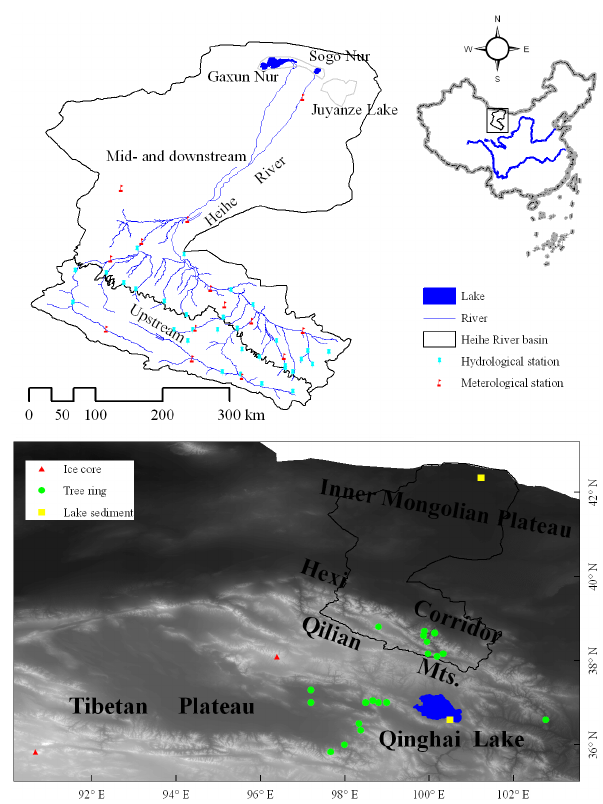
Figure 1. Location of the Heihe River basin and locations of ice core, tree ring and lake sediment